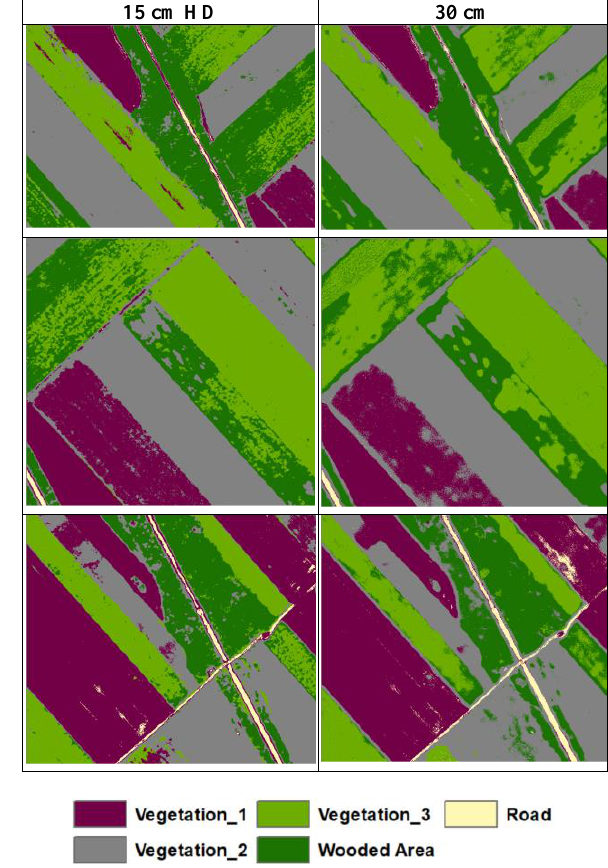
Figure 10. Image parts containing 15 cm HD and 30 cm RF model results in the Novi Sad site.